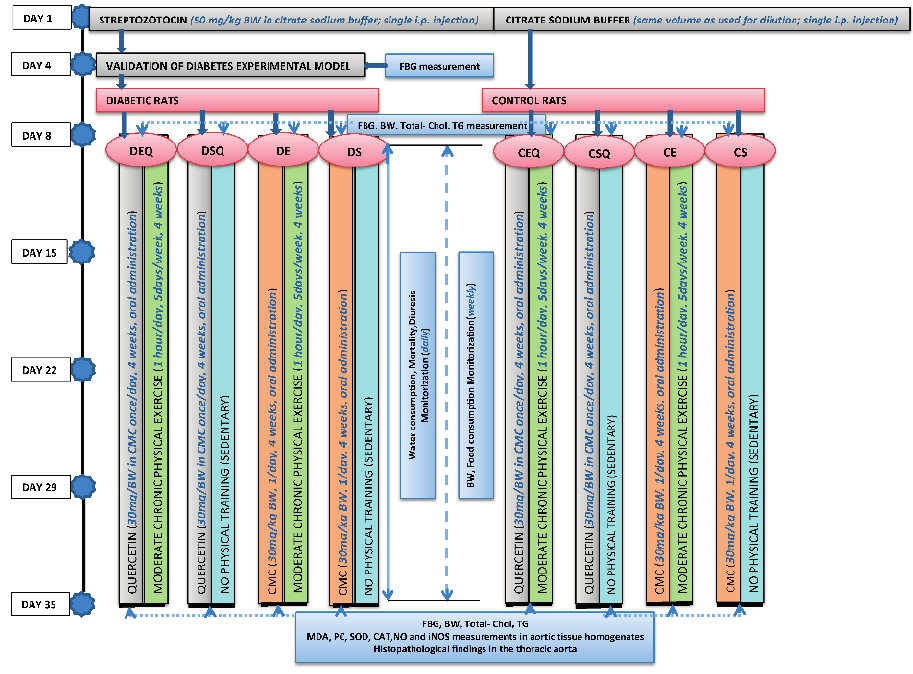
Scheme 1. The experimental